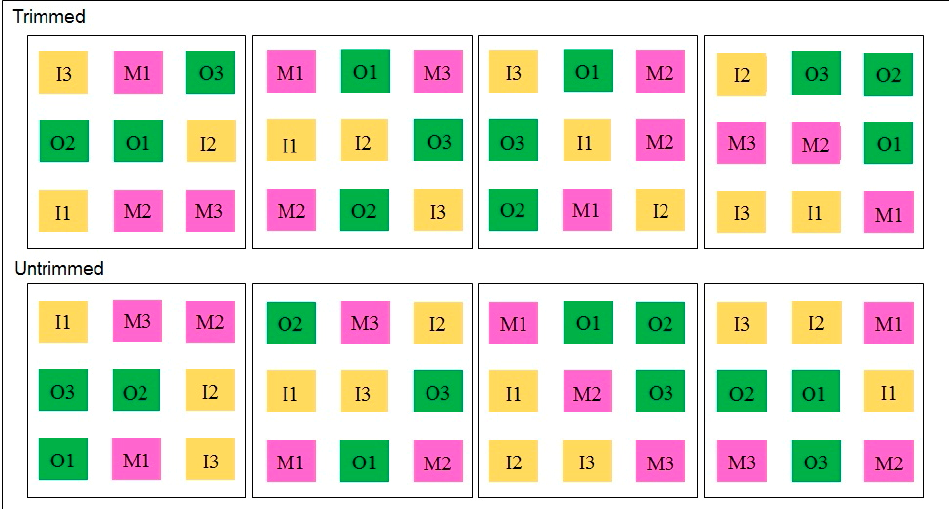
Figure 10. Layout of fertilizer trial. The letter gives the fertilizer type, O = organic, I = inorganic, M = 50:50 organic-inorganic mix based on nutrient levels. The number gives the dose rate, 1 = current farmer application rate (157 g of urea, 59 g of SP-36 {Superphosphate fertilizer}, and 42 g of potassium chloride {KCl} per coffee plant per year), 2 = recommended doses from the International Coffee and Cacao Research Institute (300 g urea, 160 g of SP-36, 200 g KCl, and 100 g Kieserite {MgS0 4 } per coffee plant per year), 3 = dose based on replacing nutrient export through harvesting (140 g urea, 72 g of SP-36, and 157 g of KCl per coffee plant per year). Within each plot (trimmed and untrimmed) there are a total of 36, 5 × 5 m trial plots, with four replicates of each dose and fertilizer combination within 4 20 × 20 m 2 blocks.